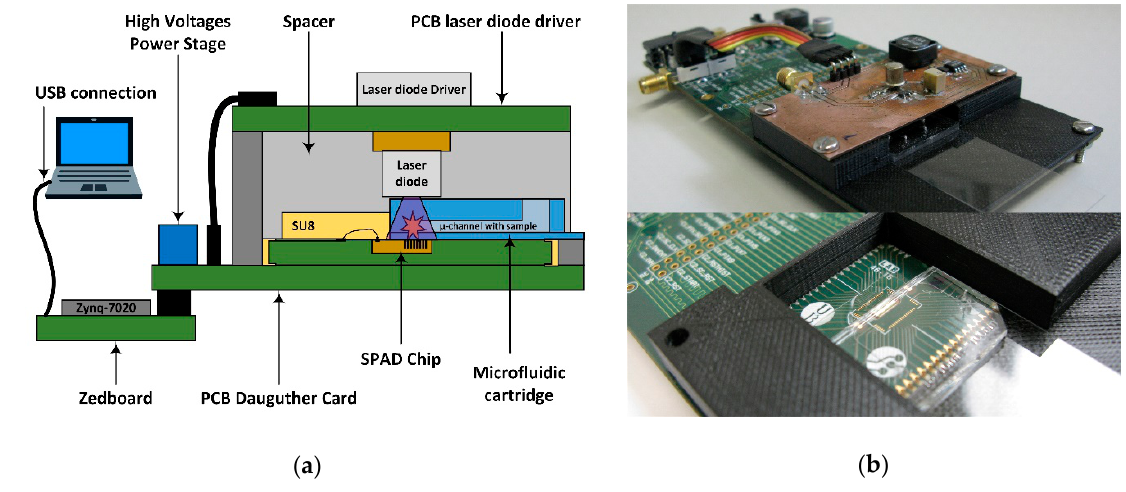
Figure 8. ( a ) Scheme diagram of the complete PoC-MD system with the detailed system stack; and ( b ) complete PCB daughter card with a detail of microfluidic cartridge guide over the SPADs sensor.